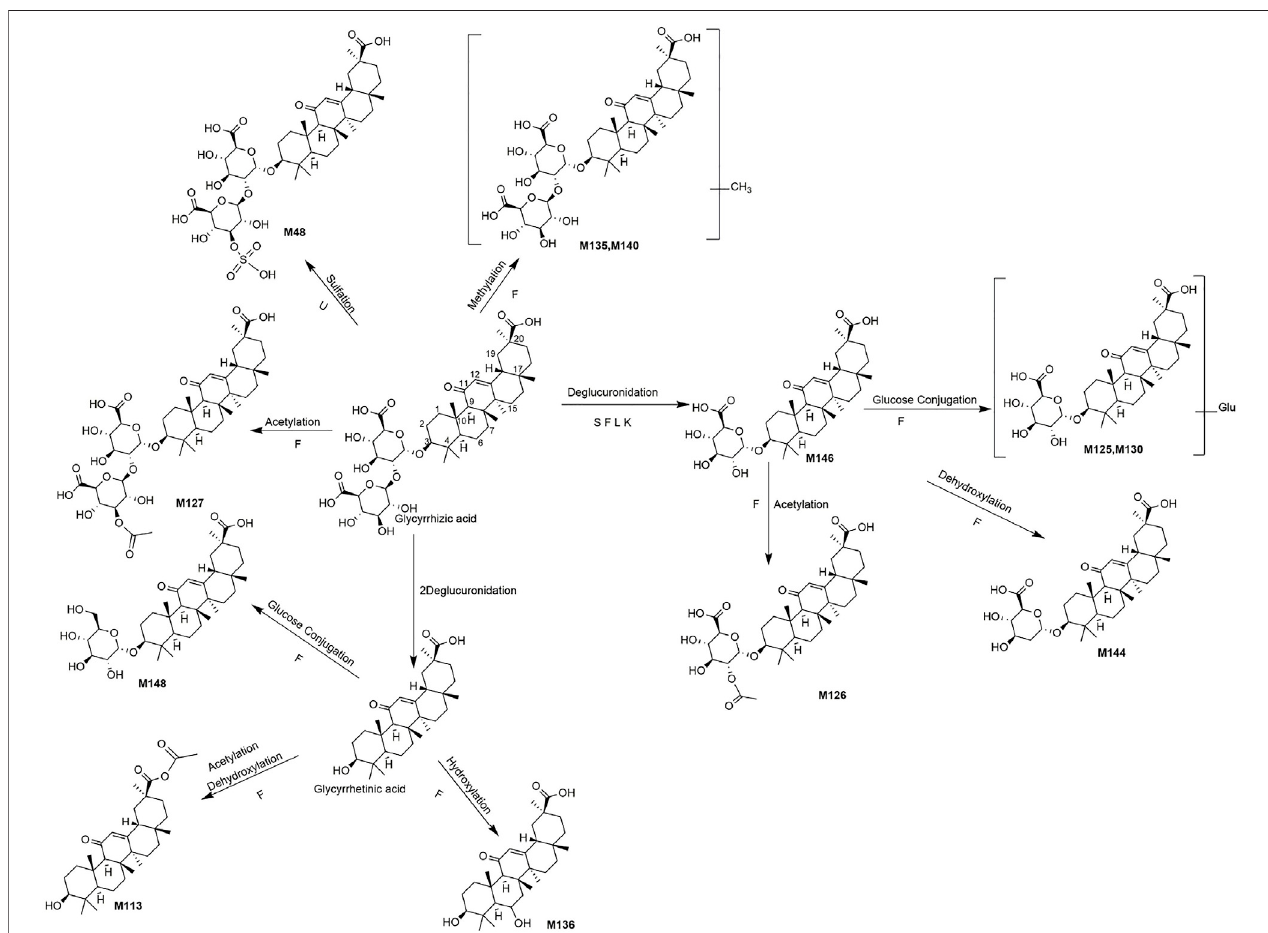
FIGURE6| Theproposedmetabolicpathwaysofglycyrrihizicacid-relatedmetabolitesinratsbiosamples.(S,H,FandUrepresentedserum,heart,fecesandurine samples, respectively).